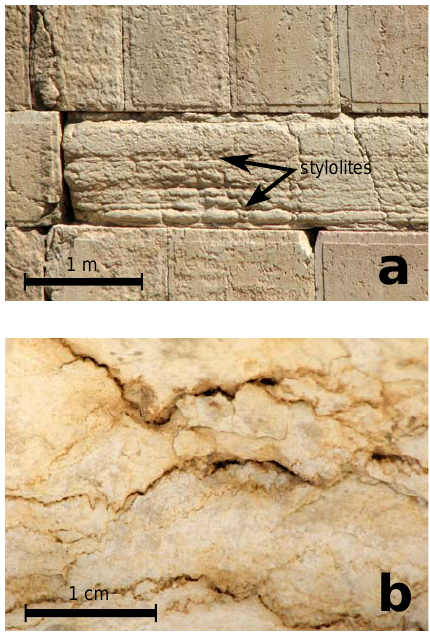
Figure 5. (a) A section of the Western Wall showing enhanced weathering in a block of micritic limestone containing stylolites. (b) Close-up of a limestone block with stylolites. The millimeter- scale gaps between the seams may be indicative of mechanical par- ticle